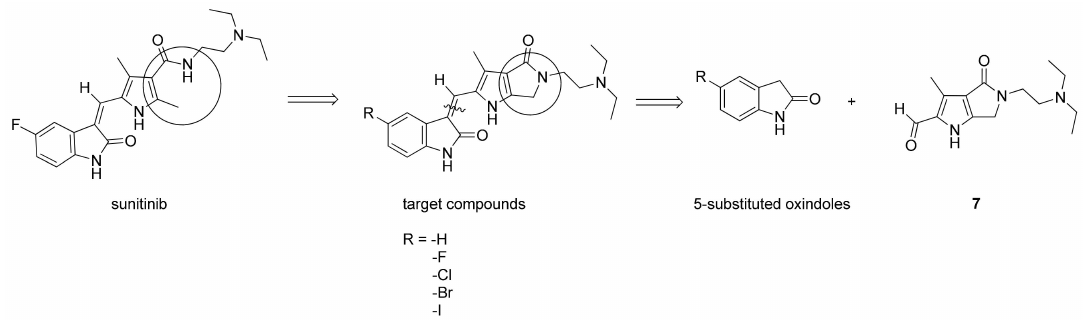
Figure 2. Drug design, and retrosynthetic approach of the target